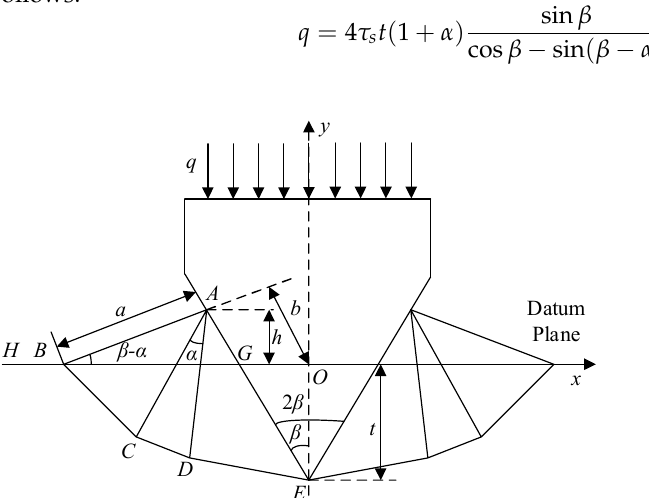
Figure 10. Slip Line Field of Rigid Wedge Pressing into Plastic Body. According to Equation (5), the relationship between wedge insertion depth and wedge tooth angle and external load is given as shown in Figure 11.